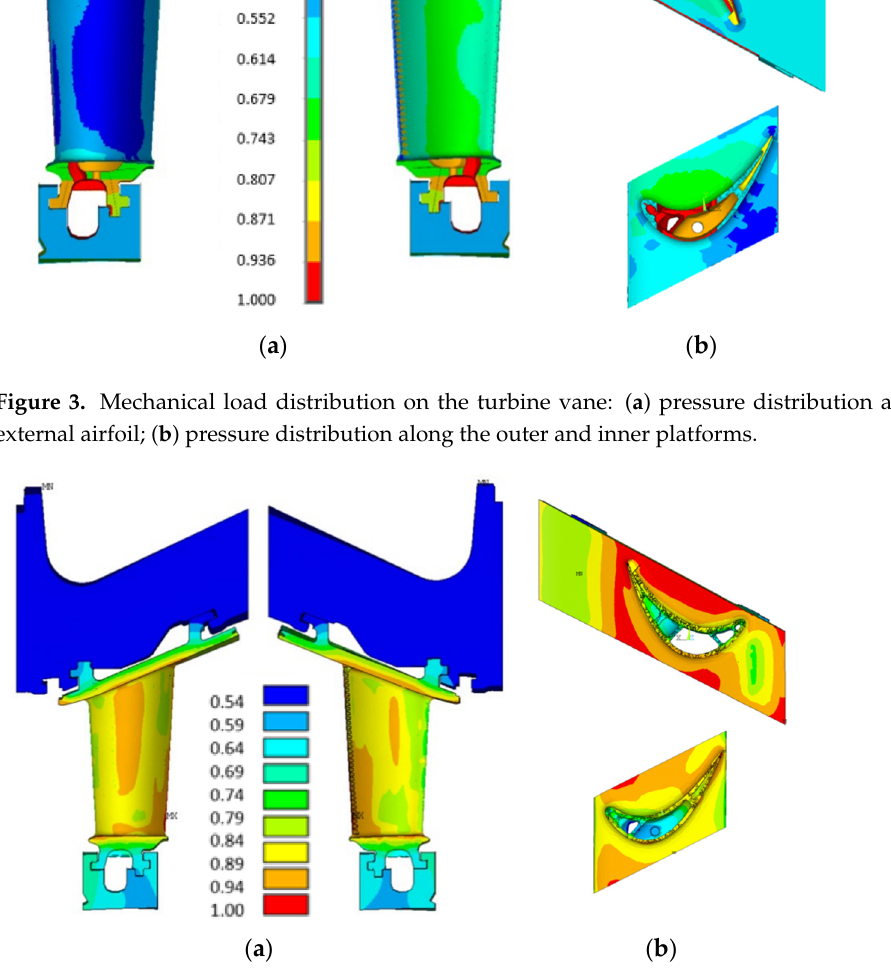
Figure 4. Temperature distribution along the turbine vane: ( a ) temperature distribution along the airfoil; ( b ) temperature distribution along the outer and inner platforms.